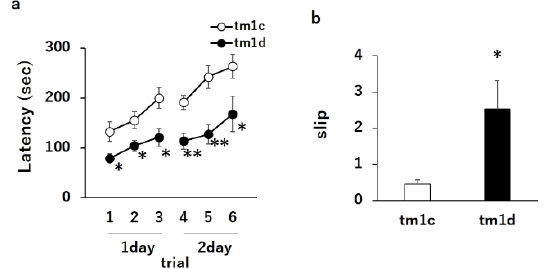
Figure 2. Motor dyscoordination in tm1d mice: ( a ) motor coordination of tm1c and tm1d mice at 16 weeks old was assessed by the accelerating rotarod test. The test was performed three times daily for 2 day (tm1c: n = 6; m1d: n = 5); * p < 0.05, ** p < 0.01, followed by Student’s t-test. ( b ) Motor coordination of tm1c and tm1d mice was assessed by the number of hind paw slips in the beam test. The test was performed five times daily for 2 day (tm1c: n = 6; tm1d: n = 5); * p < 0.05, followed by Student’s t-test. Data are expressed as mean ± SEM.